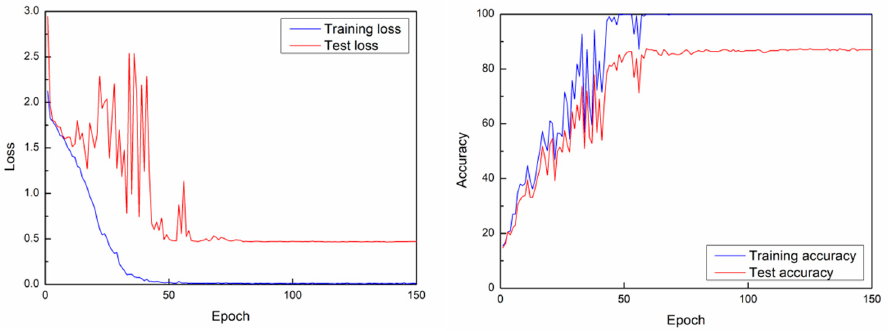
Figure 4. Learning curves and losses of training raw data (the size of training data is [1116,52,192]). The network is ResNet1D-[1,1,1,1].